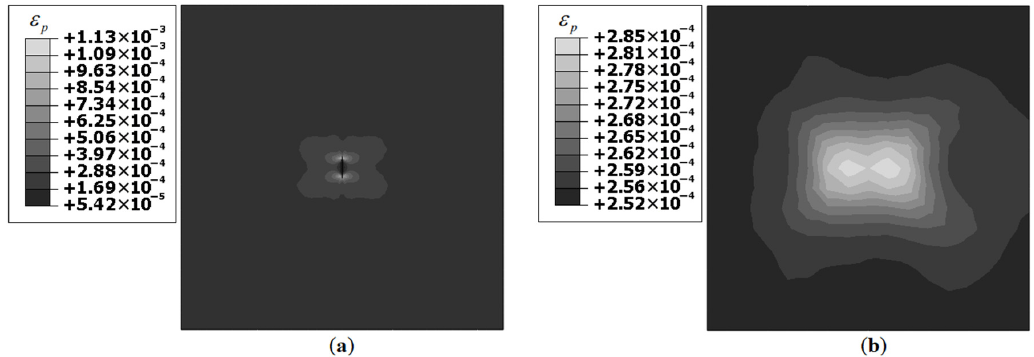
Appl. Sci. 2021 , 11 , x FOR PEER REVIEW Figure 5. Contour plots of 𝜀 (cid:3043) for Damage Case-1: ( a ) FE results, and ( b ) benchmark iFEM results. Figure 5. Contour plots of ε p for Damage Case-1: ( a ) FE results, and ( b ) benchmark iFEM results.